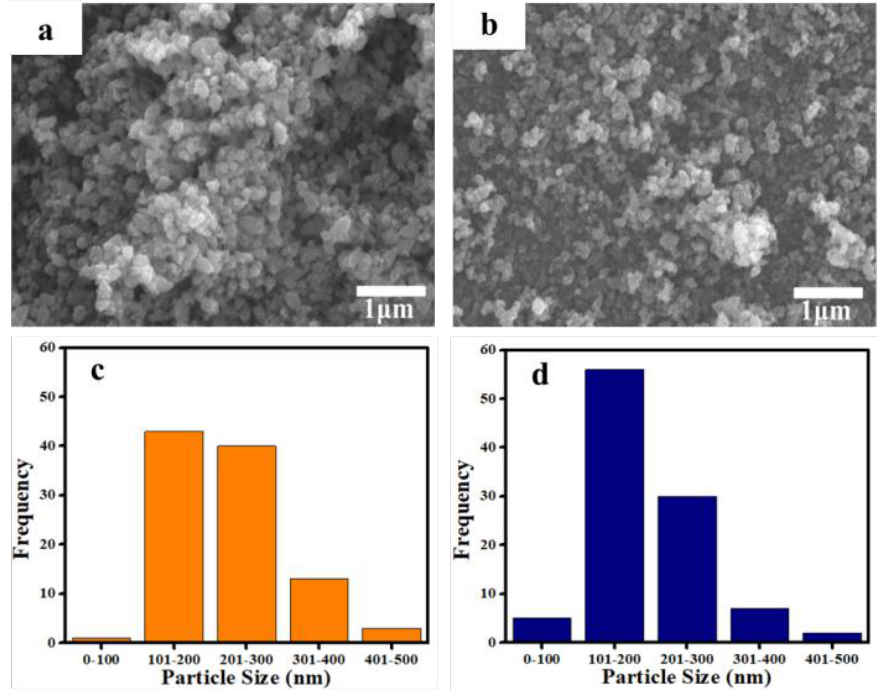
Fig. 3. SEM Images and histogram diagram of ZnO (a,c) Z-200 and (b,d) Z-500